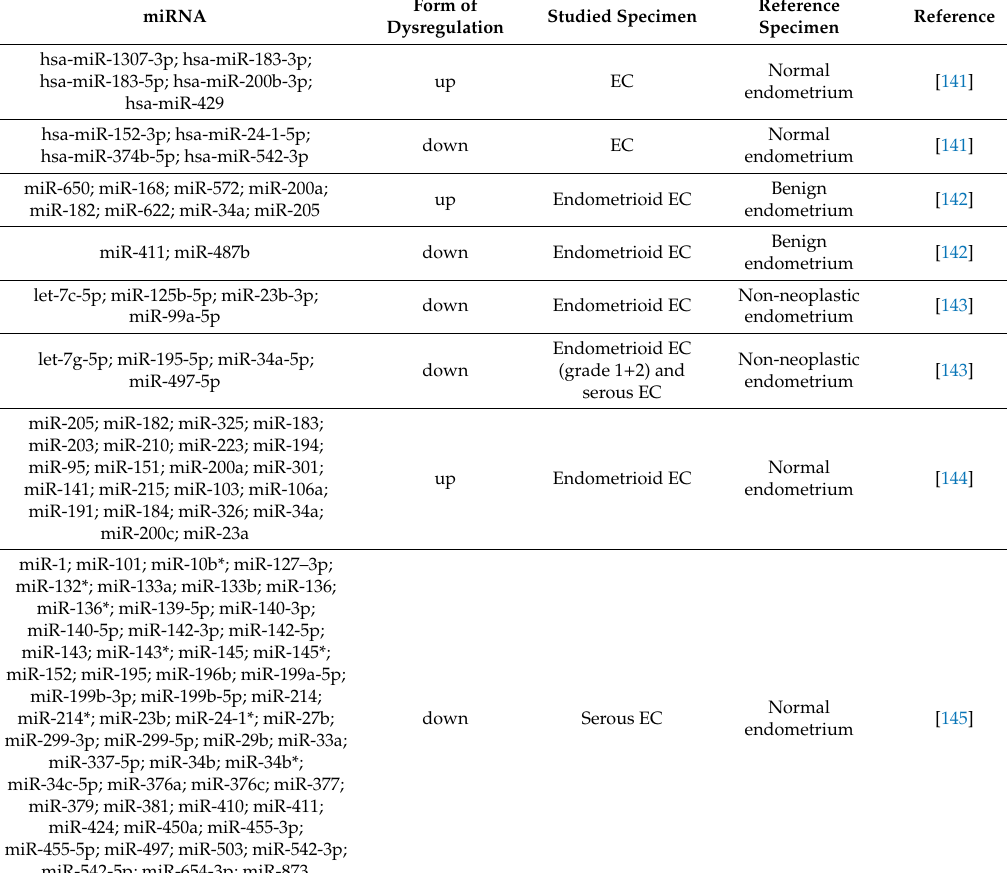
Table 2. MicroRNAs (miRNAs) found as dysregulated in endometrial cancer (EC). miRNA